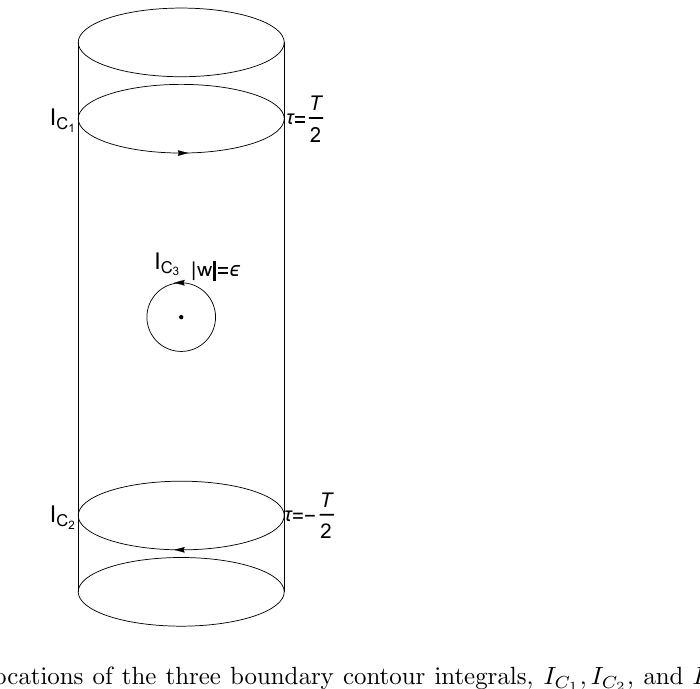
; I C , and I C 1 2 3